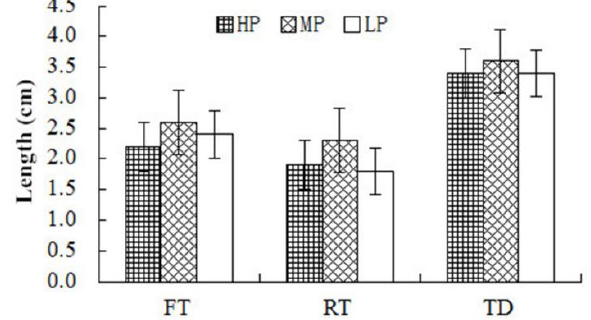
Figure 1. Udder measures of 8- to 10-month-old Holstein heifers fed varied dietary phosphorus (P). LP, low P; MP, medium P; HP, high P; FT, front teat length; RT, rear teat length; TD, teat distance, distance around gland front to